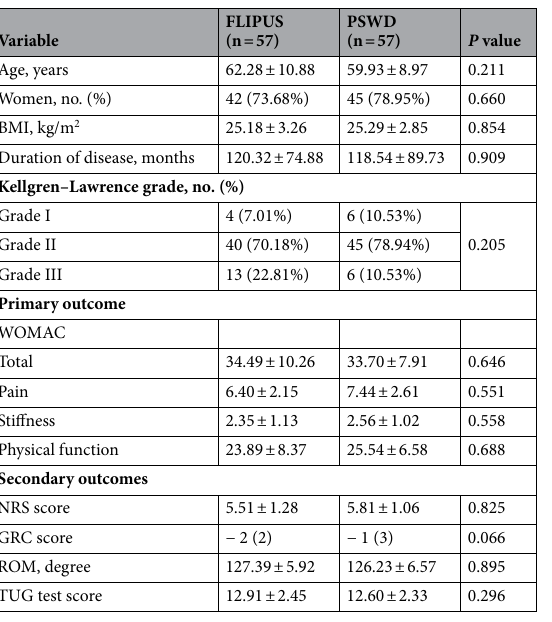
Table 2. The baseline demographics and clinical features of patients. FLIPUS focused low-intensity pulsed ultrasound, PSWD pulsed shortwave diathermy, BMI body mass index, WOMAC Western Ontario and represented as the mean ± SD (normally distributed data) or median (IQR) (nonnormally distributed data). Enumeration data are represented as frequencies